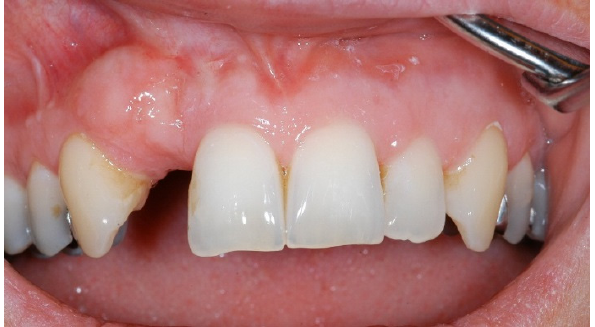
Figure 4. Integrated autologous soft tissue graft before exposure of the